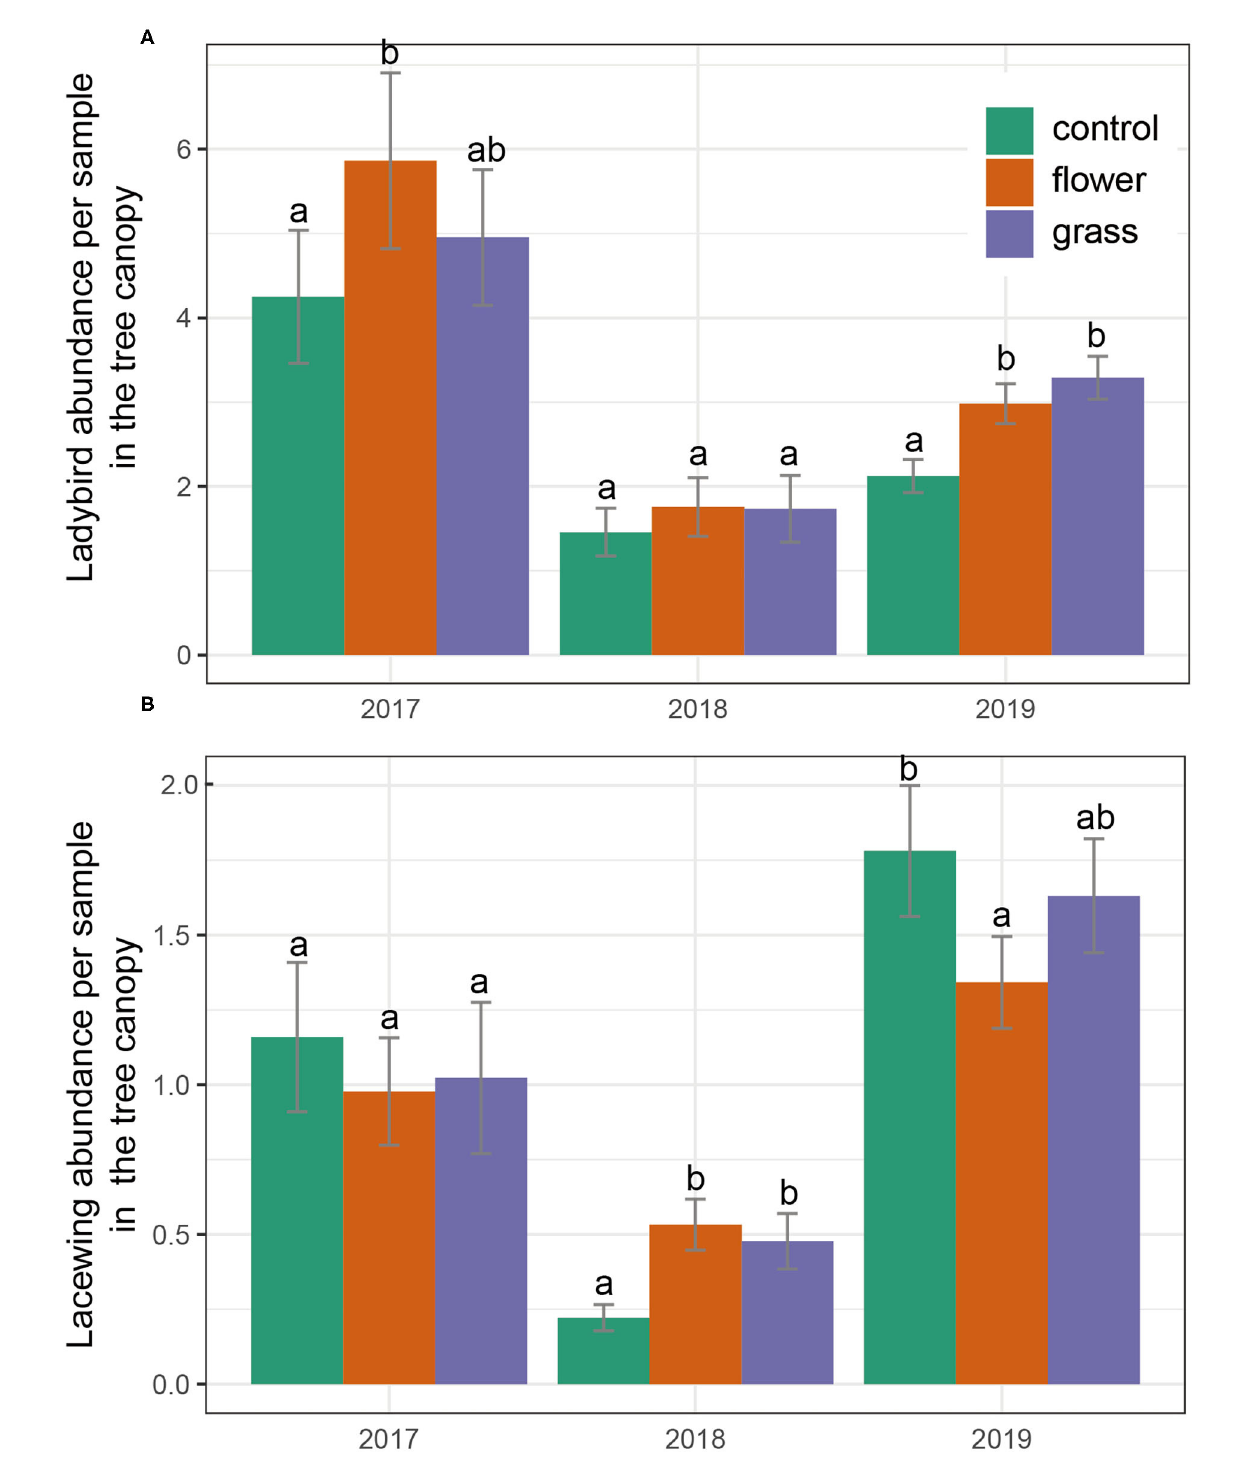
FIGURE 4 | (A,B) Predator abundances (mean ± SE) in the tree canopy during the 3 years (2017–2019). Within each year, bars capped with the different letter are significantly different ( P < 0.05).